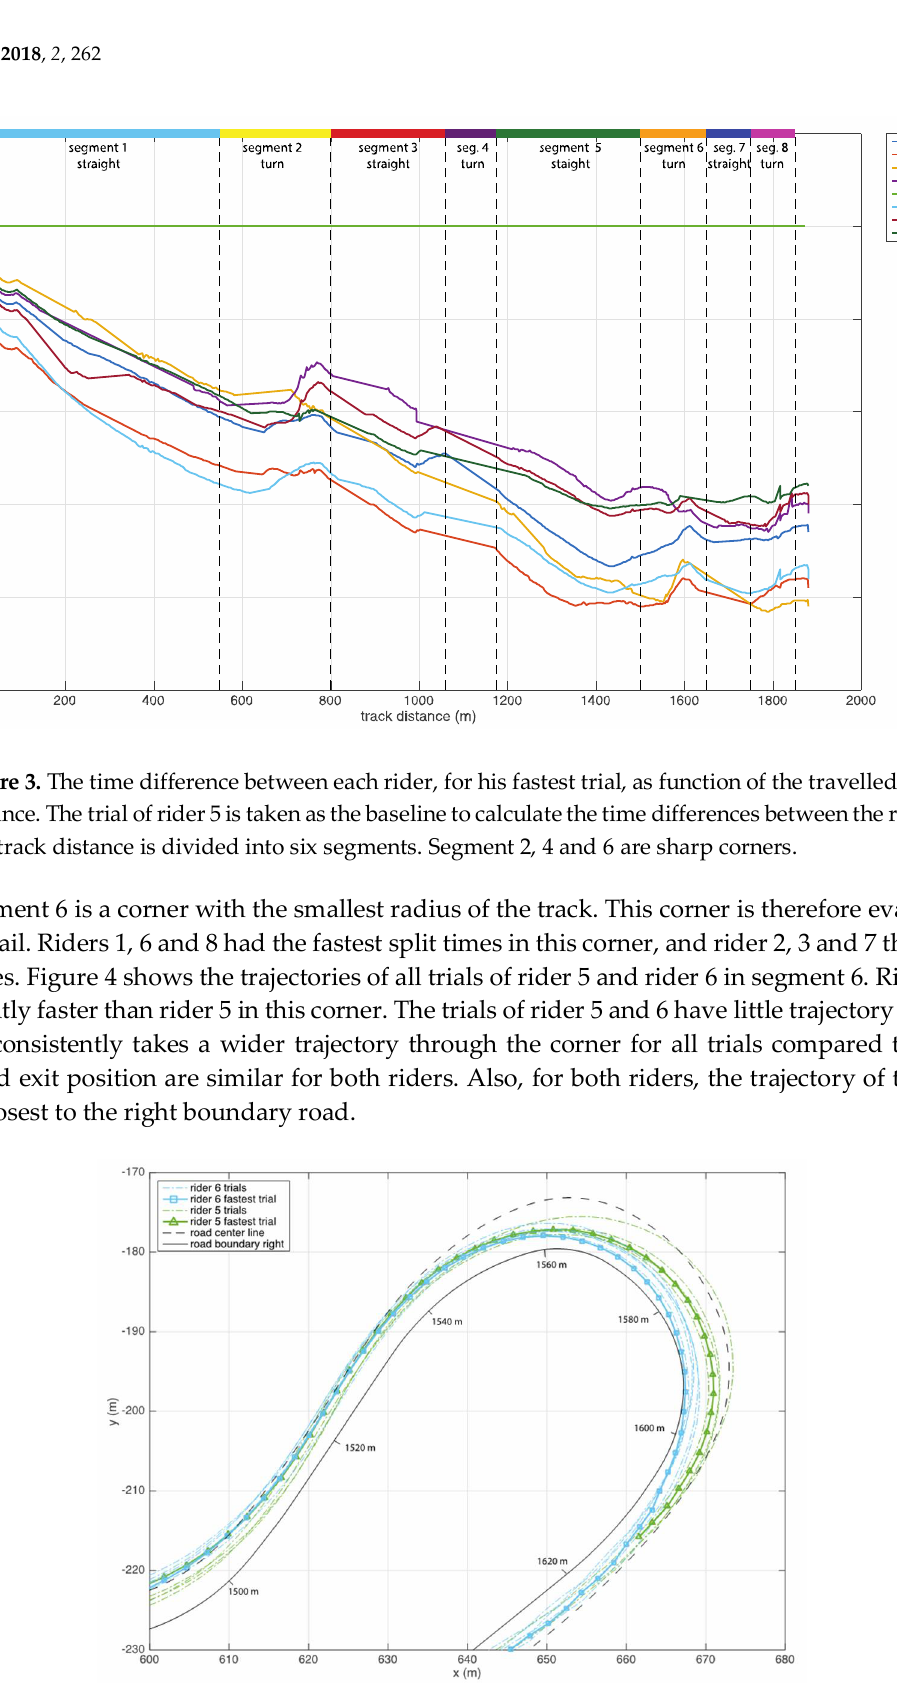
Figure 4. The trajectories of all trials of rider 5 and rider 6 for segment 6 (turn 3). This is the sharpest right-handed turn of the descent. The trajectory of the fastest trial of each rider is bold and highlighted with a marker. The track boundaries for the right lane of the road are plotted in black. The dotted line indicates the centerline of the